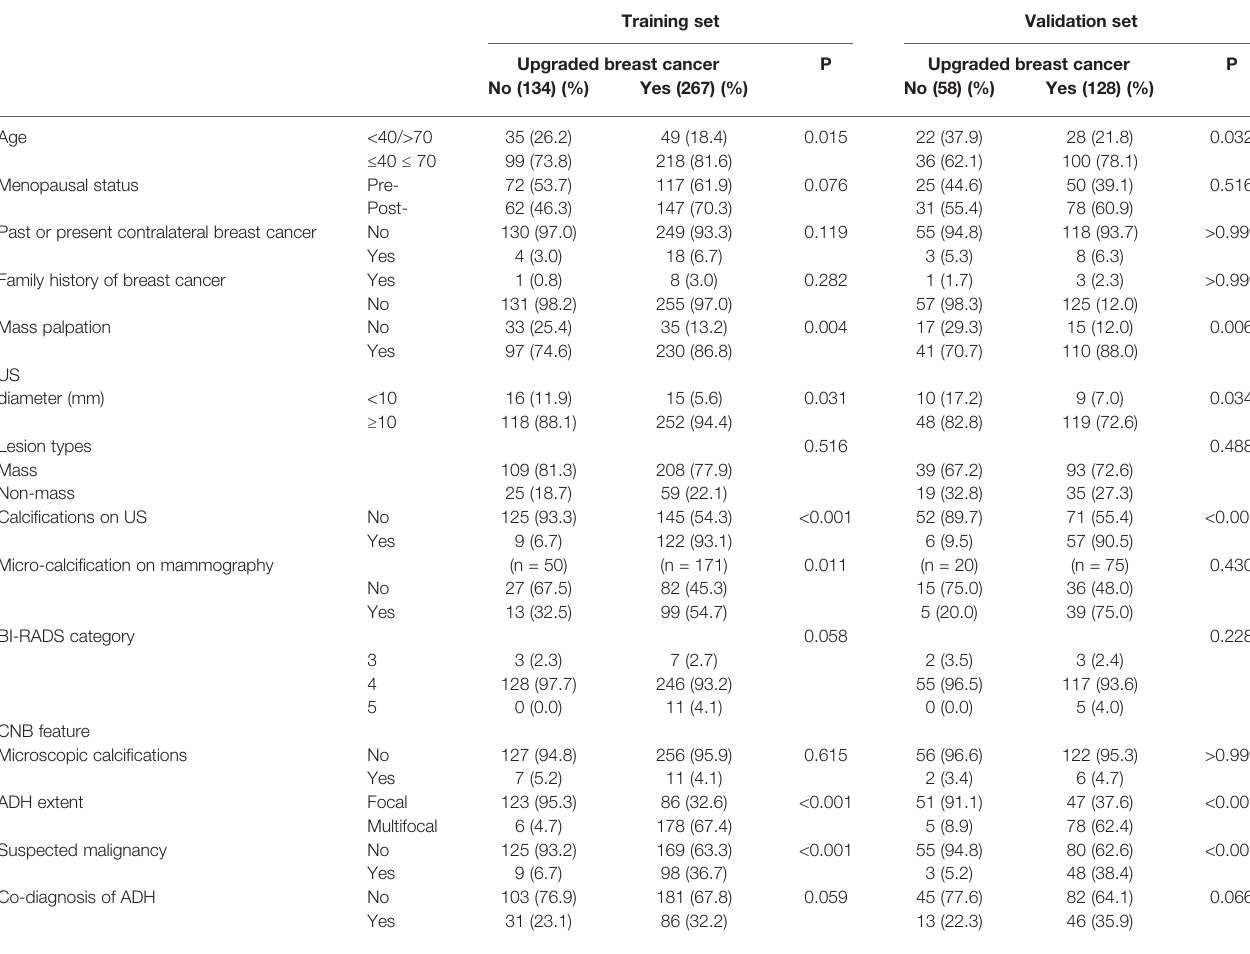
TABLE 1 | Clinicopathological and US factors correlations with upgrades in the training and validation sets.